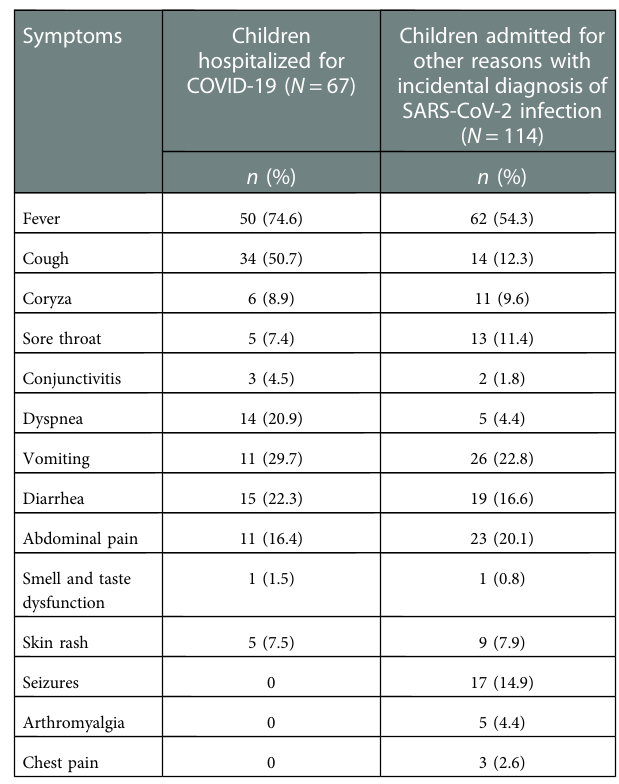
TABLE 1 Demographic characteristics of study population. TABLE 2 Clinical manifestations in children hospitalized for SARS-CoV-2 infection and in those admitted for other reasons and with an incidental diagnosis of SARS-CoV-2